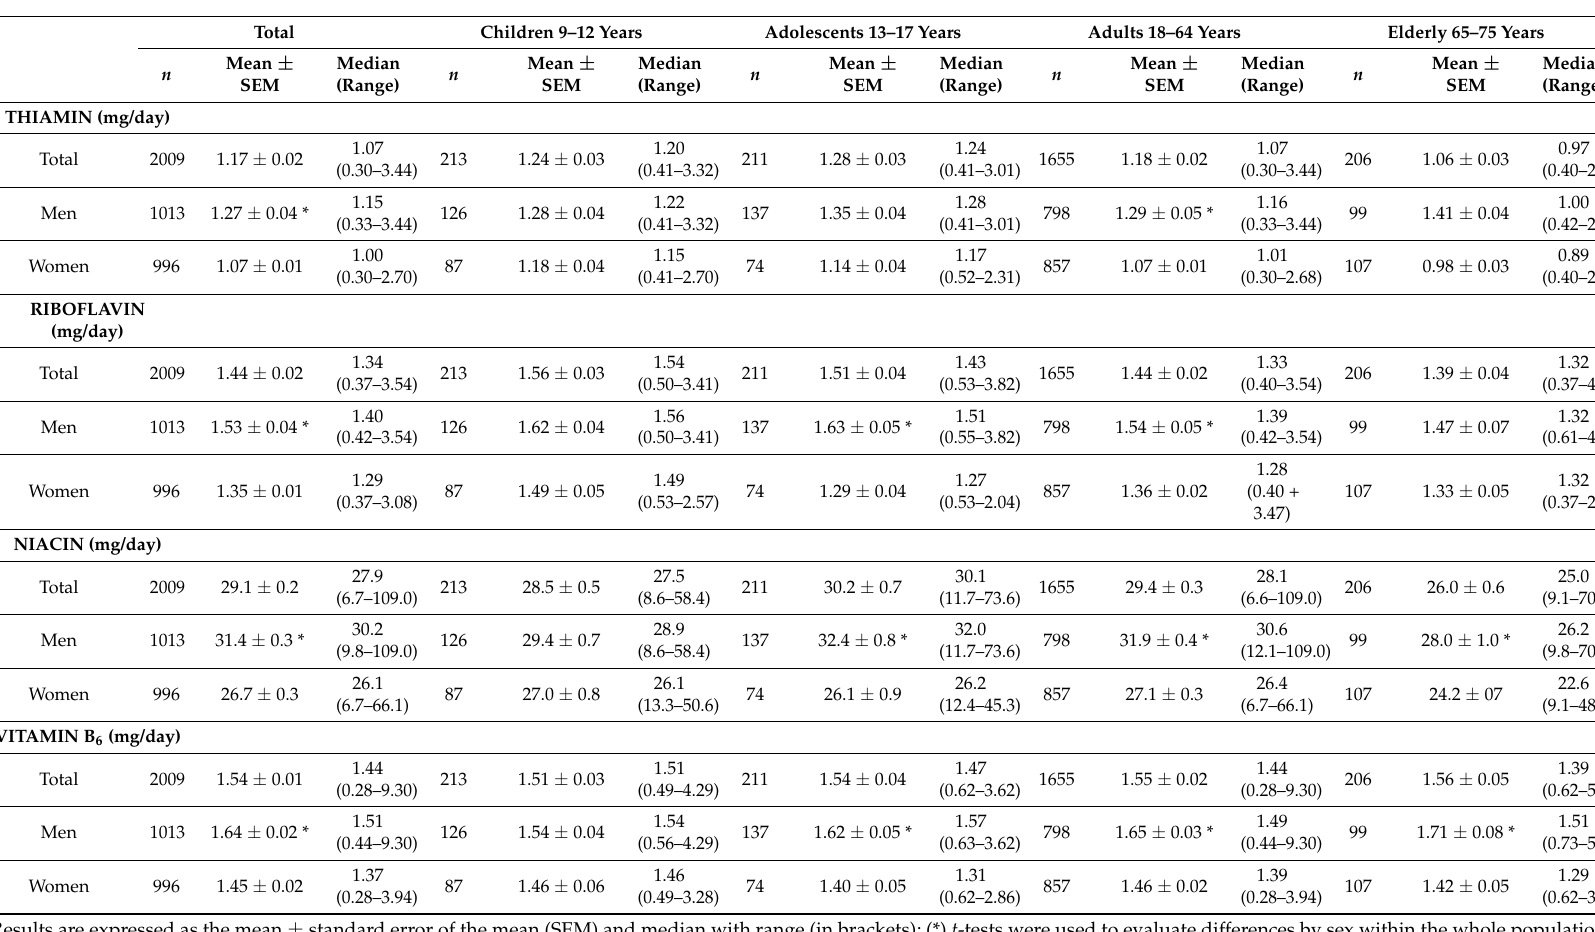
Table 2. Daily Thiamin, Riboflavin, niacin, and vitamin B 6 reported intake by sex and age group in the ANIBES Study